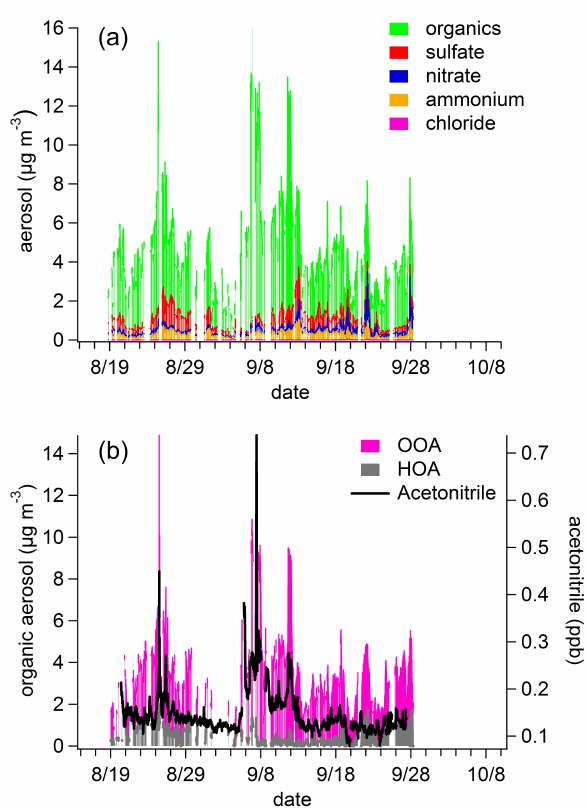
Fig. 1. (a) Bulk aerosol composition (organics, sulfate, nitrate, am- monium and chloride) as measured by the aerosol mass spectrome- ter (AMS), indicating the prevalence of the carbonaceous fraction. (b) Organic aerosol divided into “hydrocarbon like” (HOA) and “oxygenated” (OOA) shown along with acetonitrile, a gas phase tracer for biomass